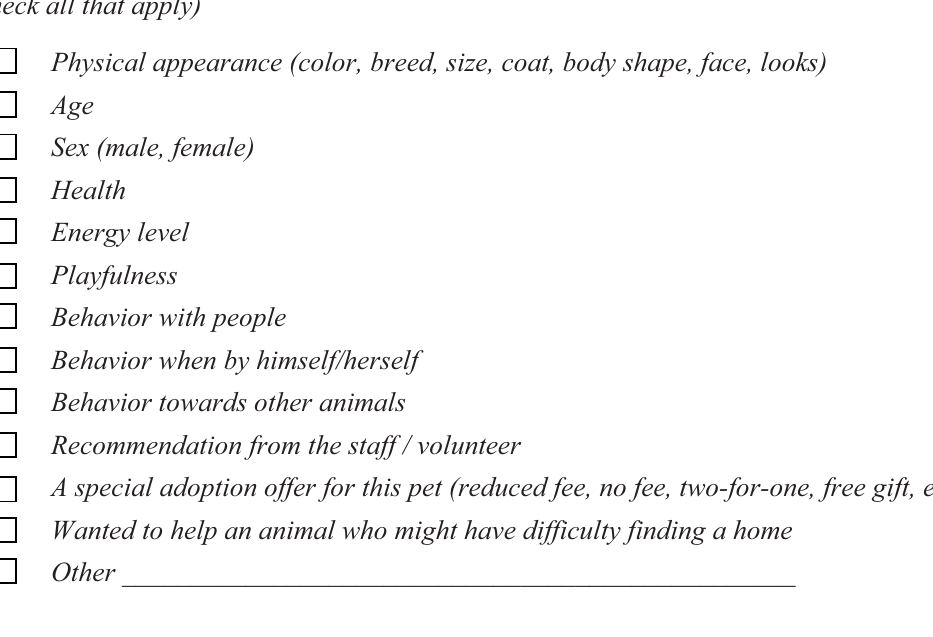
Figure 1. Adopter survey given to all five animal